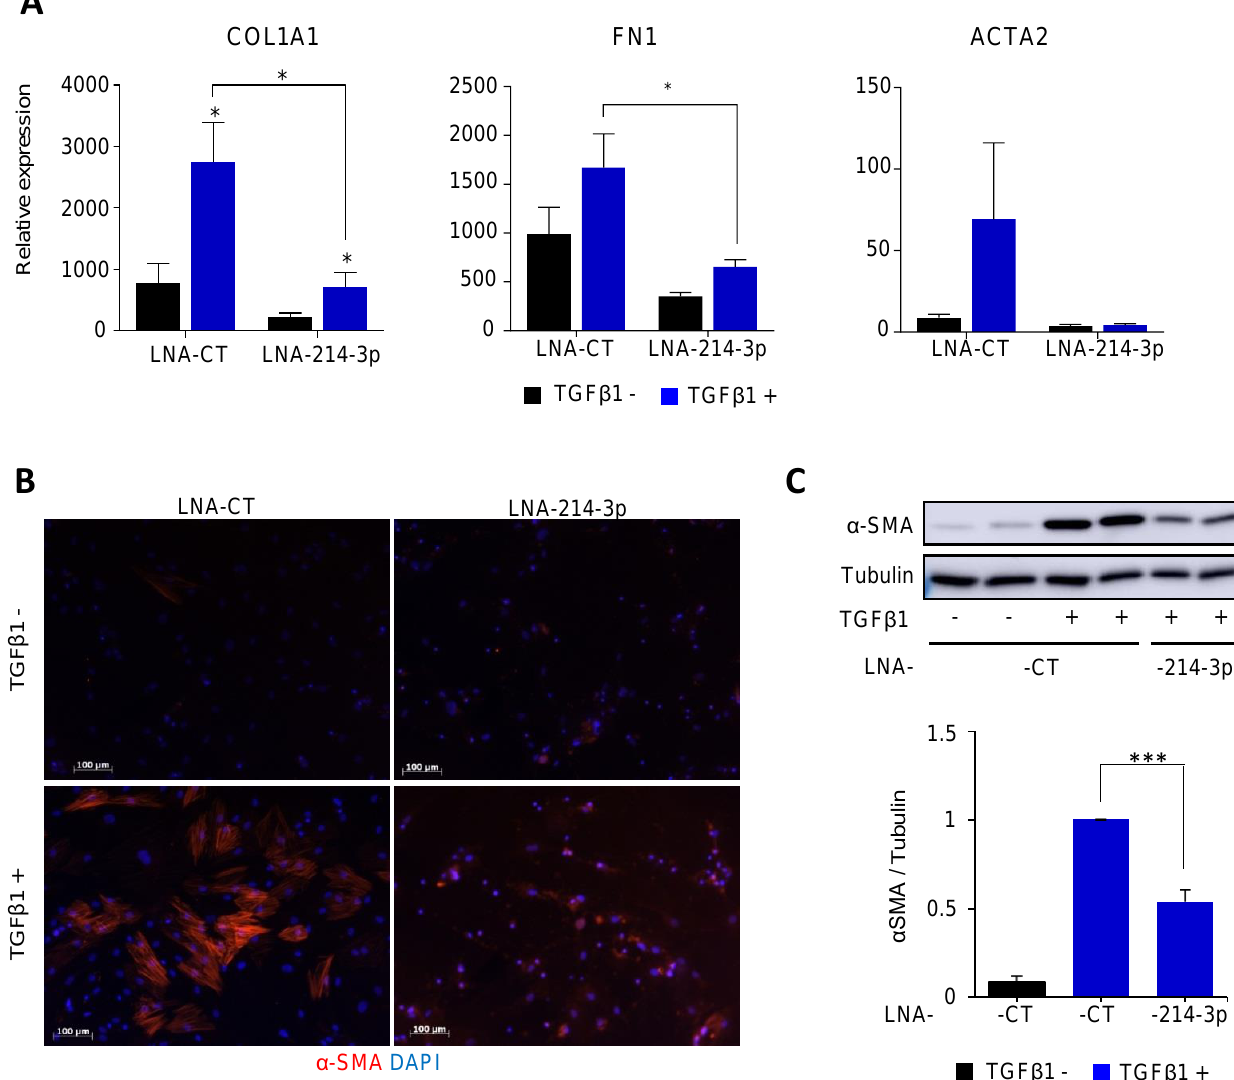
Figure 3. Knockdown of miR-214-3p inhibits FAP fibrogenesis. FAPs were transfected with 10 µ M LNA-214-3p or LNA-CT for 24 h, then cultured with differentiation medium supplemented with 1.5 ng/mL TGF β 1 for 2 days. ( A ) COL1A1 , FN1 and ACTA2 fibrogenic genes were measured by quantitative RT-PCR versus TBP housekeeping gene. Experiments was performed on three distinct biopsies. Data are express as mean ± SEM. * p < 0.05. ( B ) α -SMA immuno-labelling revealed α -SMA-expressing fibers (red) present in myofibroblasts. Nuclei were labelled with DAPI (blue). The images are representative for all fields. The white bar represents 100 µ m. ( C ) α -SMA proteins were detected by immunoblot. Tubulin was used as loading control. One of three independent replicates is shown. Quantification is shown as mean ± SEM. *** p <